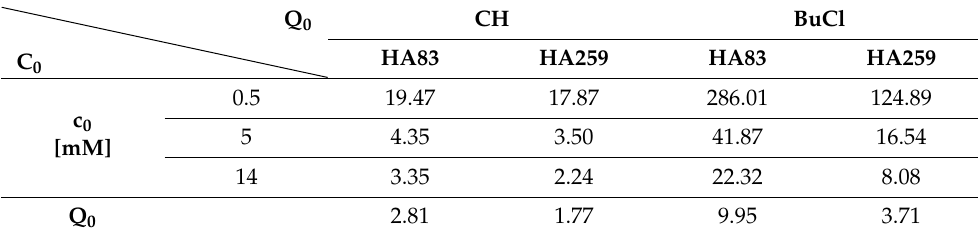
Table 3. Surface area of hydroxyapatite per one TEMPO molecule (nm 2 ) for the chosen experimental data points (c 0 ) and for the calculated maximum adsorption capacity values (Q 0 ).